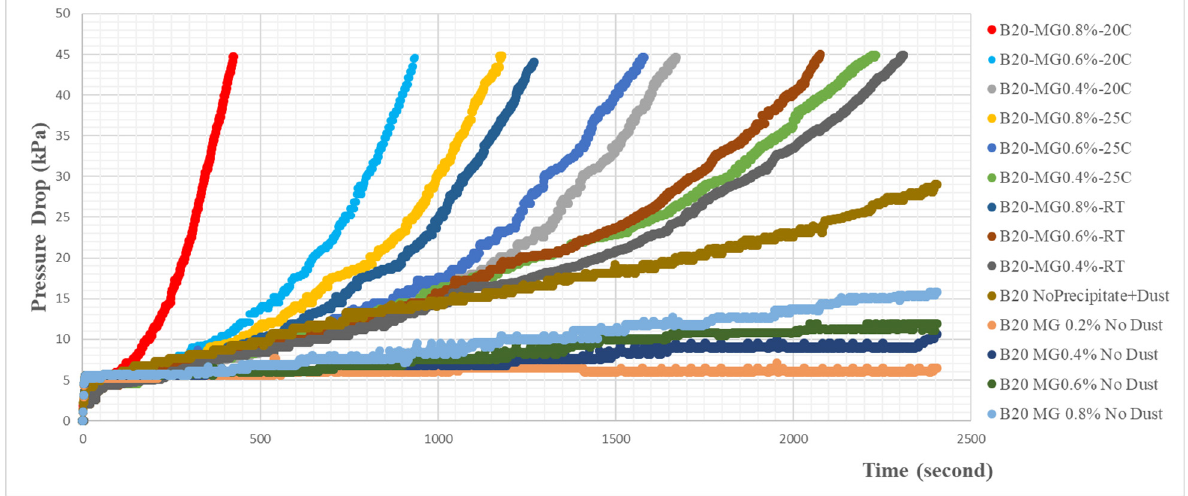
Figure 4. Graph of pressure drop trend for the different conditions of soaking temperatures and monoglyceride content in B20 fuel.